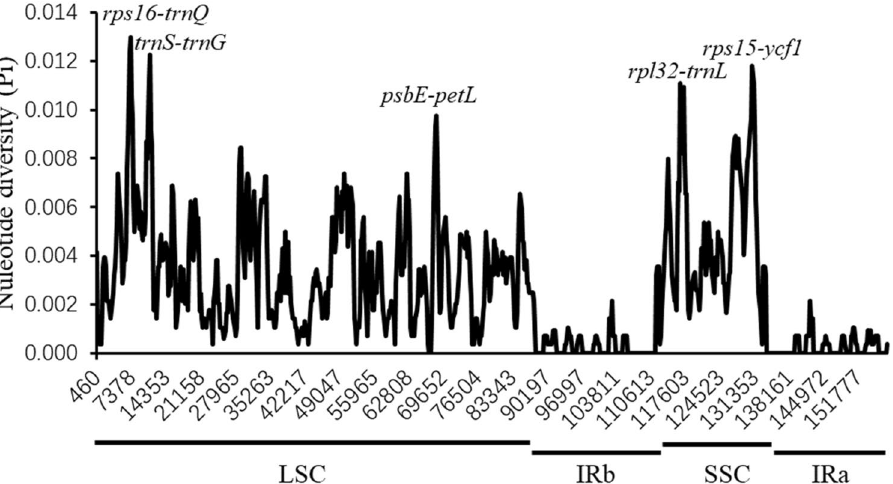
Figure 3. Position of the midpoint in the window Sliding window plots of nucleotide diversity (pi) across the complete chloroplast genome of the seven Citrullus species. Window length: 800 bp; Step size: 200 bp.